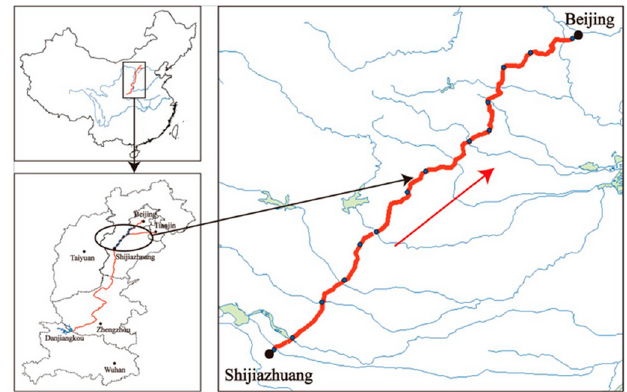
Figure 19. Middle Route Project (MRP) for South-to-North Water Transfer [25].